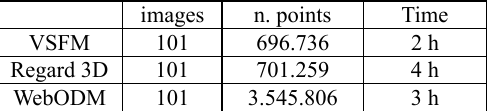
Table 1: Surveys data